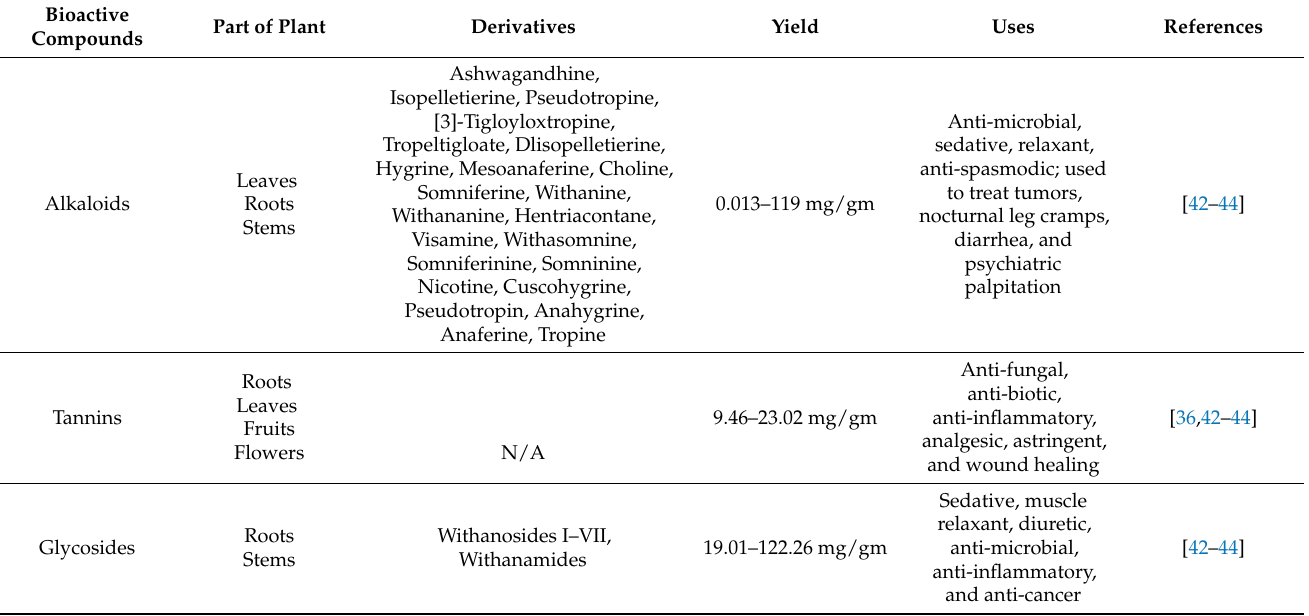
Table 5. Various chemical constituents and their derivatives found in Withania somnifera